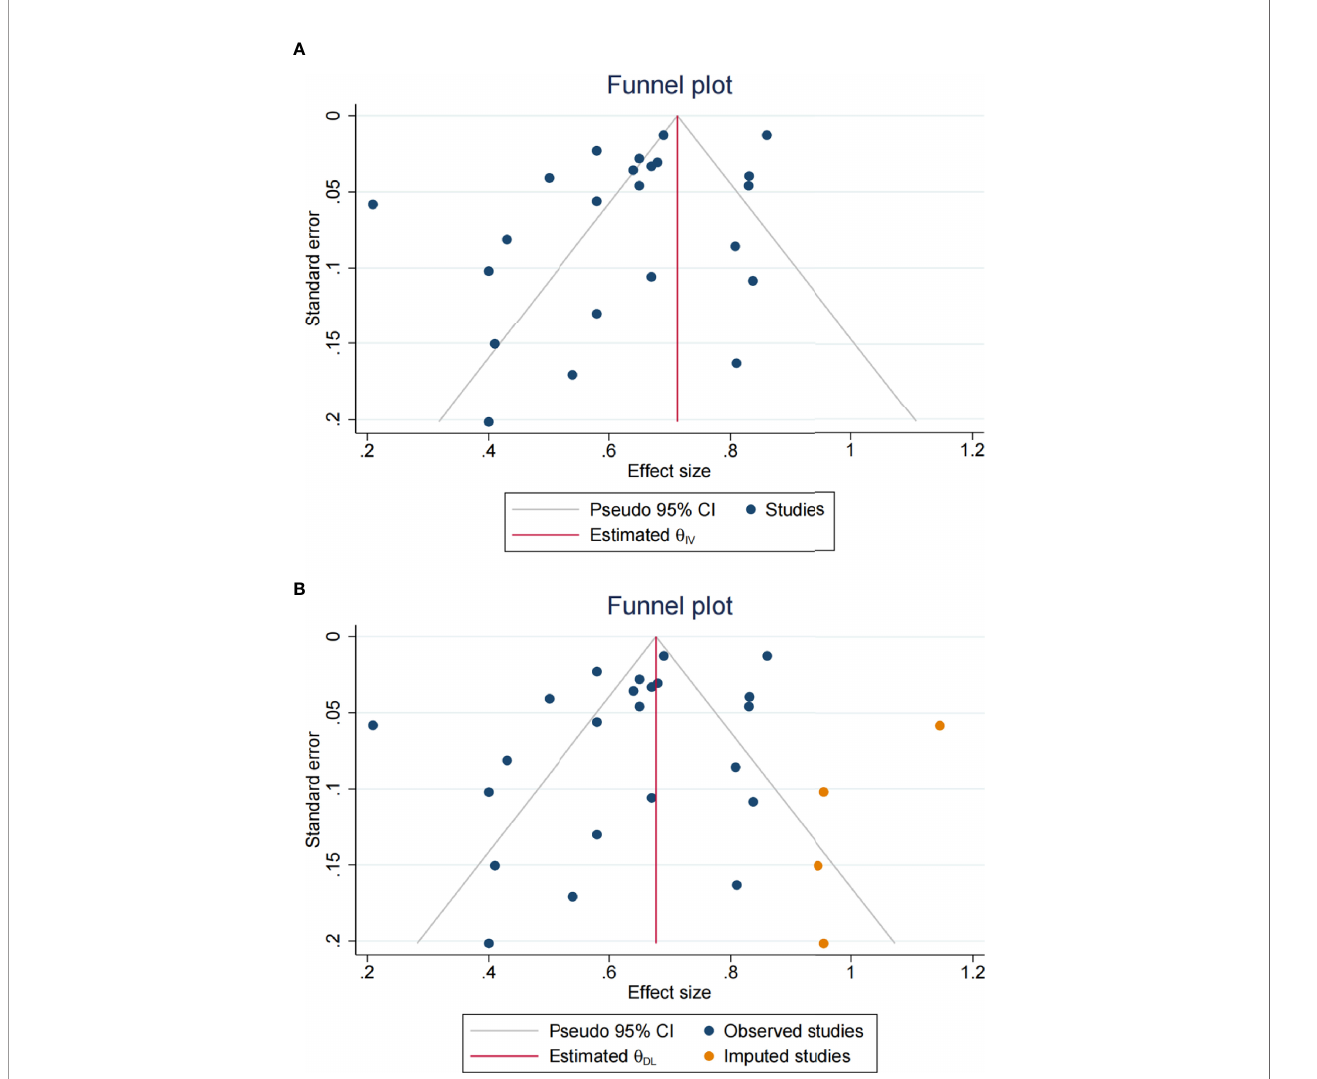
FIGURE 3 | Publication bias assessment. (A) The funnel plot; (B) four hypothetical studies were observed through the trim-and- fi ll